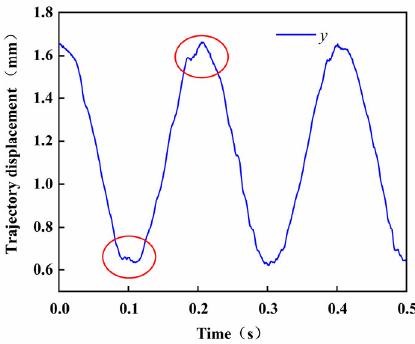
Figure 10. Trajectory tracking in Y ‐ direction under centralized control.